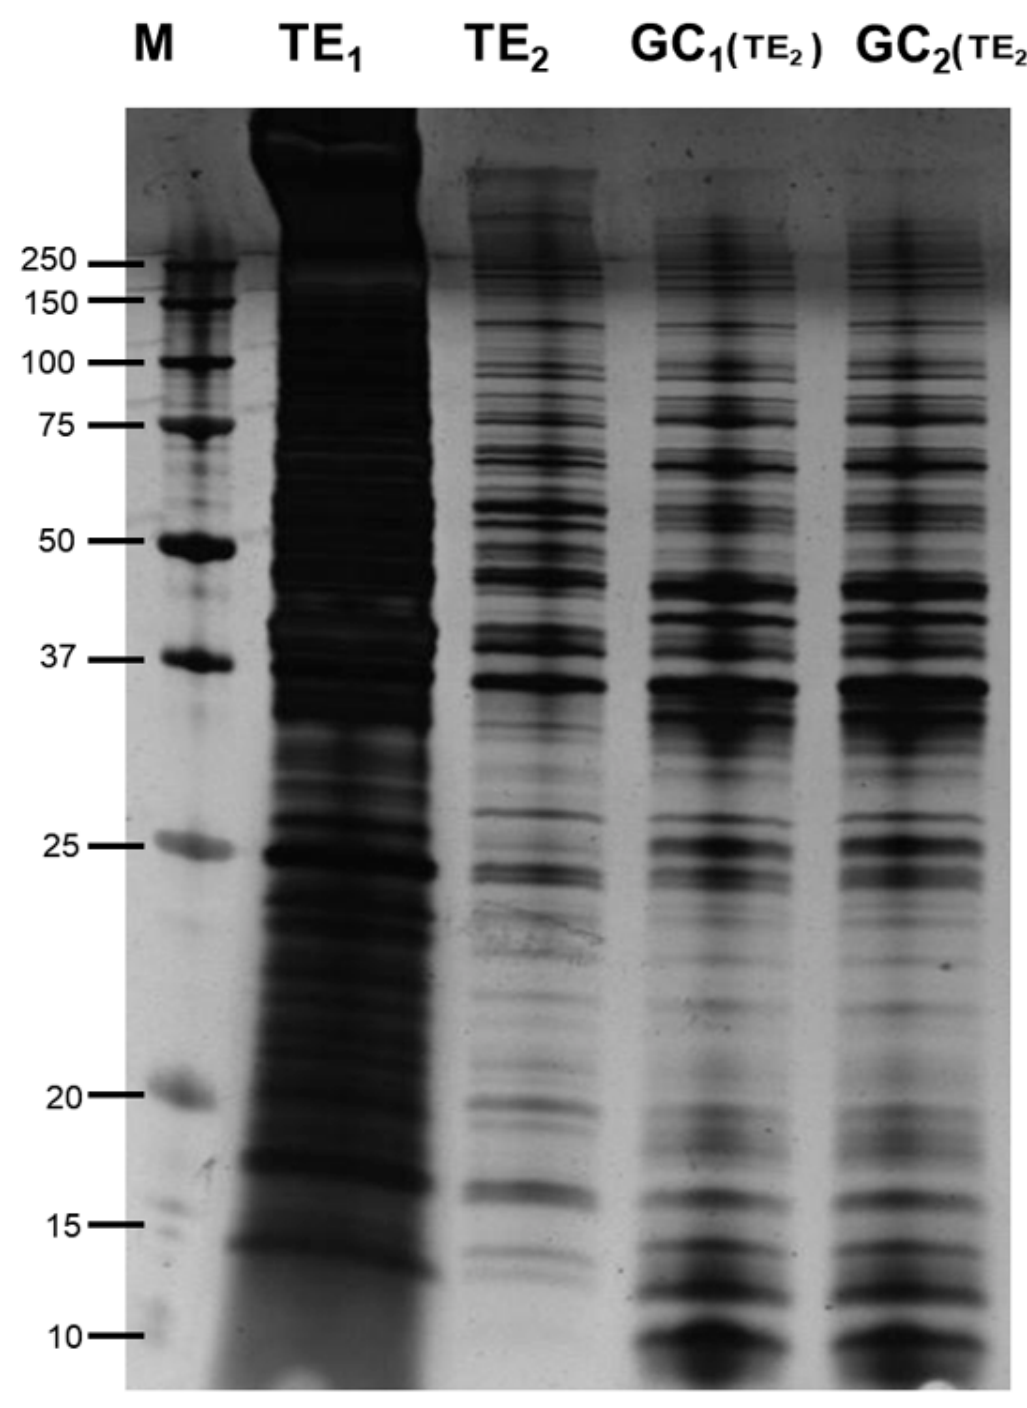
Figure 1. Monochromatic silver staining of total extracts and gland cell extracts of A. simplex (GC = gland cells), (TE = total extracts); (TE 1 = denaturing), (TE 2 = not denaturing). GC 1 and GC 2 are two technical replicates with phosphate.